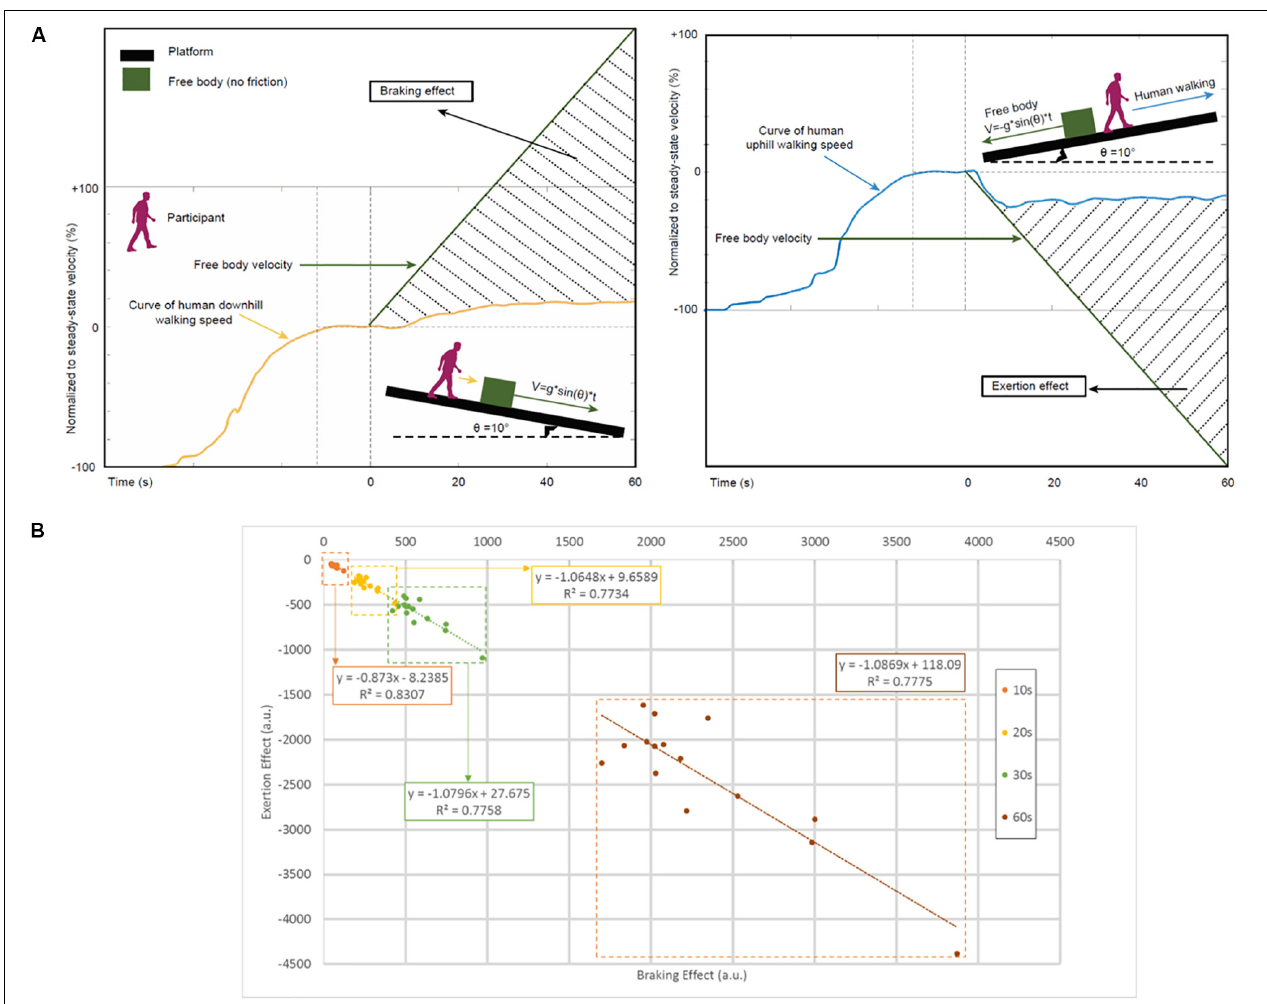
FIGURE 3 | The relation of locomotion and gravity while walking in inclined planes. (A) Schematic characterization of the braking (left panel) and exertion (right panel) effects. We introduce a new measure for estimating braking (positive values) and exertion (negative values) effects by calculating the shaded area using numerical integration ( Supplementary Figure S1 and section Materials and Methods). Free body velocity was rescaled to permit graphical comparison on the same scale as the walking data. (B) Relationship between braking effect and exertion effect. Scatterplots and linear regression lines for the relationship between estimated braking and exertion effects in study participants included separate time windows covering the entire experimental period: at 10 s (orange), 20 s (yellow), 30 s (green), and 60 s (brown) post-transition from steady-state velocity. Regression equations and r-squared values are shown. The correlations represented in these data suggest similar volitional effort to counteract the natural tendencies imposed by gravity in uphill and downhill walking. a.u., arbitrary